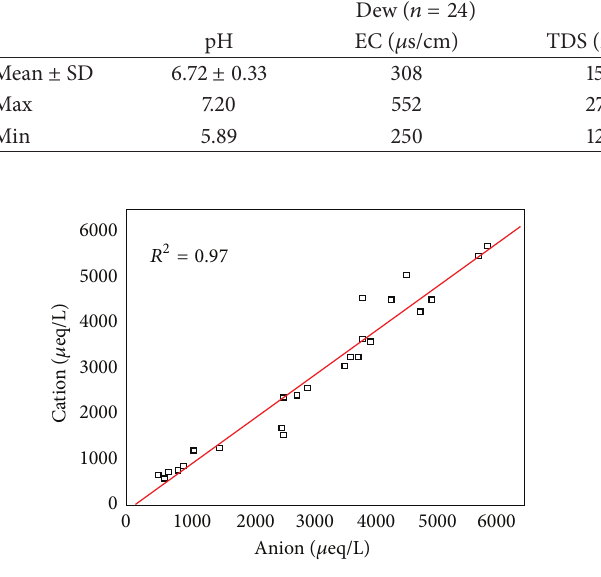
Figure 1: Correlation among sum of total cations (TC) and total anions (TA) in dew water of Changchun